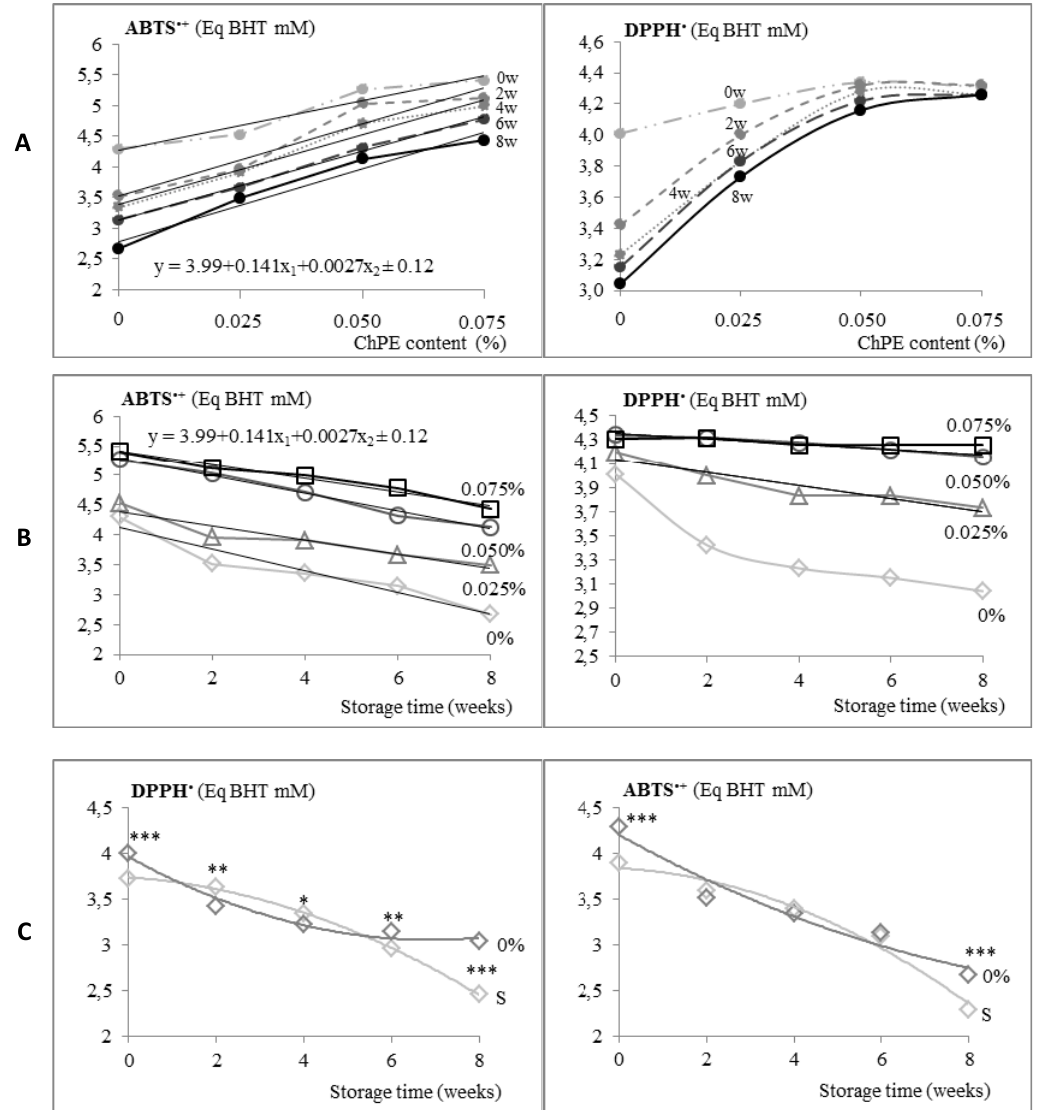
Figure 1. Antioxidative potential of muffins differing in ChPE (chokeberry polyphenol extract content); 0–0.075% ( A , B ) and in muffins containing sucrose (S) ( C ) throughout 8 weeks of storage. 0w–0-weeks of storage; 2w–2-weeks of storage; 4w–4-weeks of storage; 6w–6-weeks of storage; 8w–8-weeks of storage.